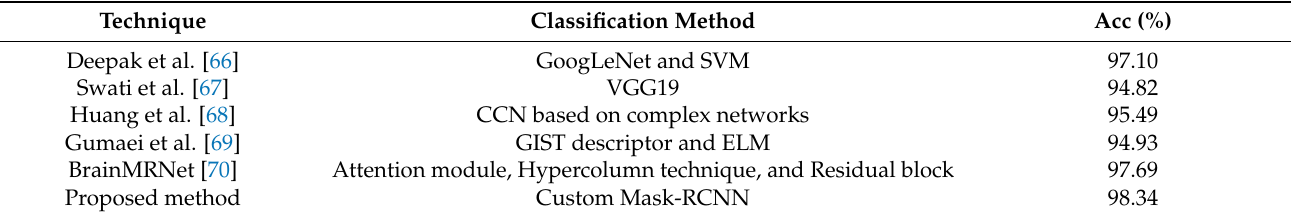
Table 4. Comparison of our method with other classification